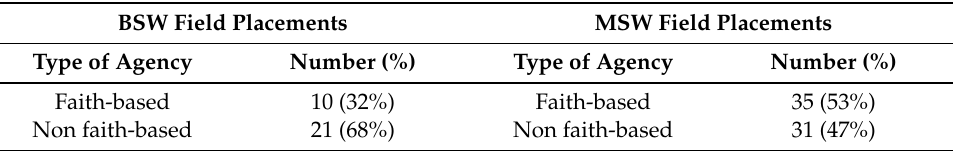
Table 1. Snapshot of Social Work